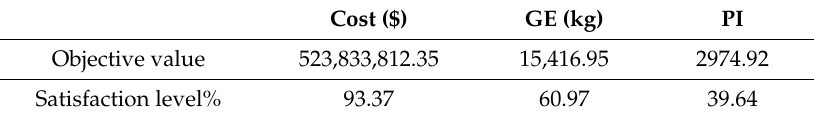
Table 18. Optimal values of all objectives and satisfaction level of each objective.